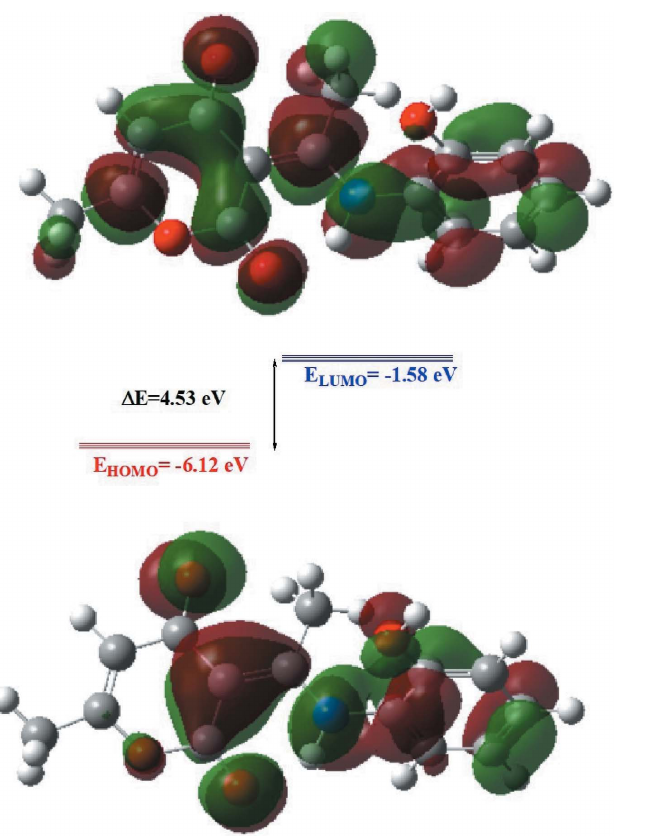
Figure 9 MEP surfaces mapped from the optimized geometries of the B3LYP/6– 311 G calculation.